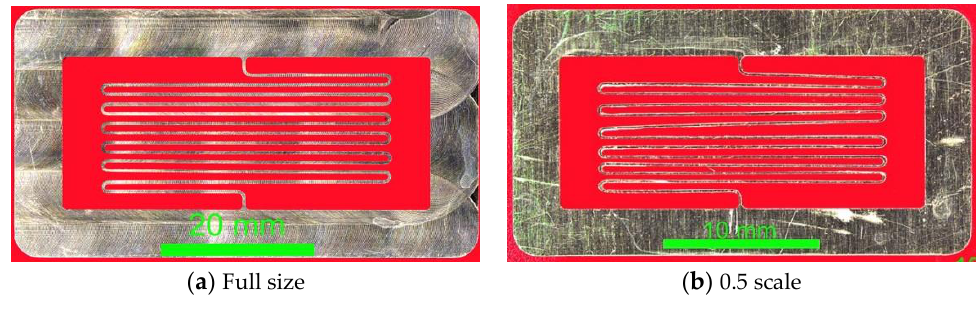
Figure 12. Aluminum flexures – Neo at Datron.